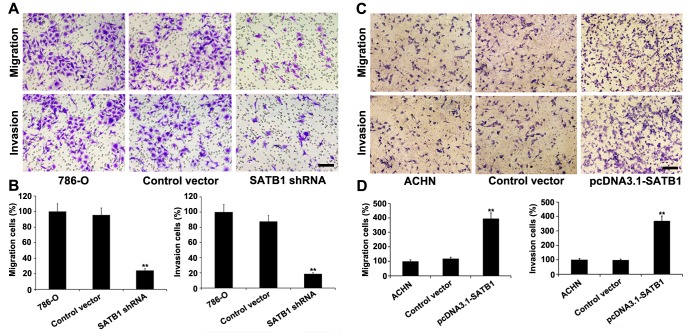
Cell migration and invasion potential in vitro were evaluated by transwell migration and invasion assays.
A, Silencing of SATB1 inhibited the cell migration and invasion capability of 786-O cells. B, Quantitative analysis of the number of 786-O cells that successfully migrated and invaded. C, SATB1 overexpression promoted the migration and invasion of ACHN cells. D, The number of migrated and invaded ACHN cells increased with SATB1 upregulation. Scale bar: 10 µM. Data were shown as mean ± SD (n = 3). **P<0.001. Magnification: 200×.